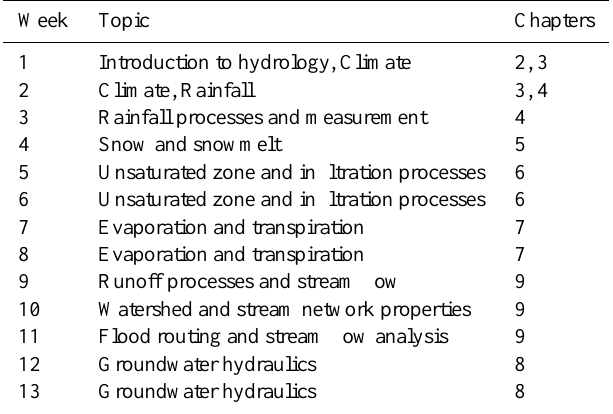
Table A1. Course